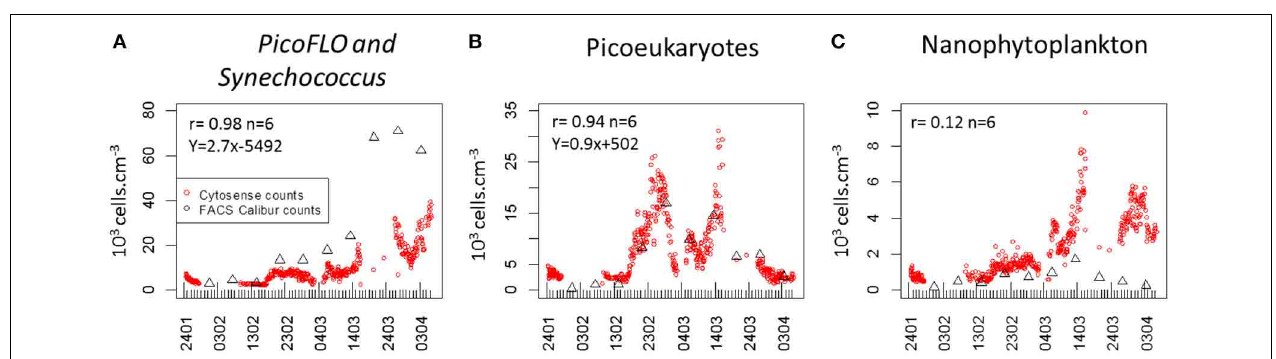
FIGURE 6 | Comparison of abundances determined with the FACSCalibur flow cytometer (black triangles) and the CytoSense flow cytometer (red dots). Pearson rank correlation [(r) between the two